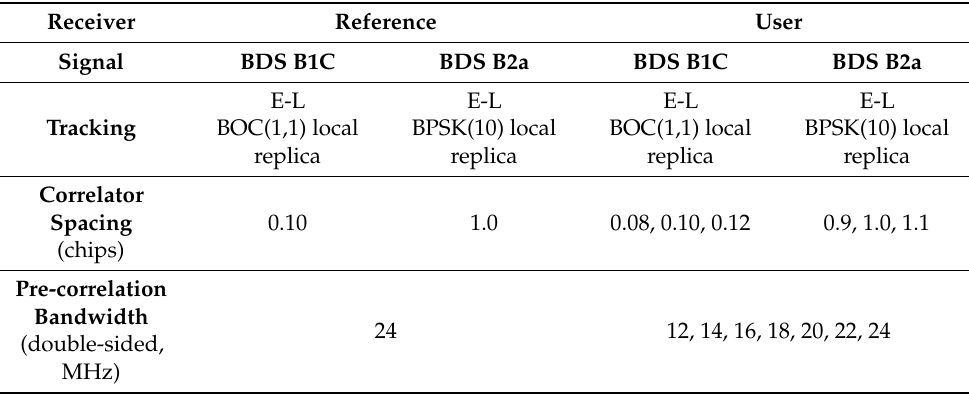
Table 4. Configurations of reference and user